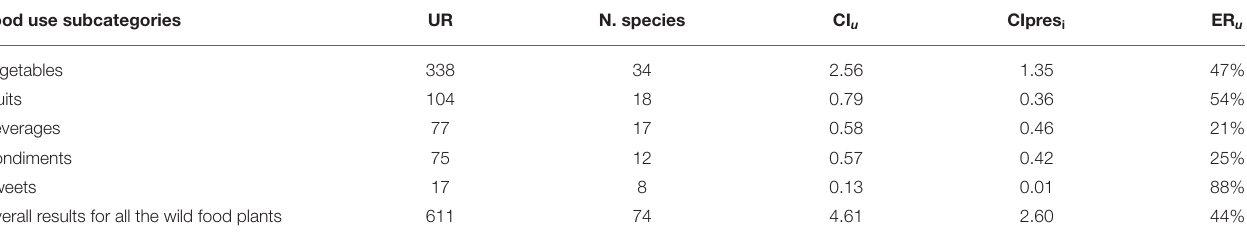
TABLE 2 | Summary of the results of the interviews ( N = 132) about all the food use subcategories: number of use-reports, number of species, total and present cultural importance index, and erosion rate. Food use subcategories UR